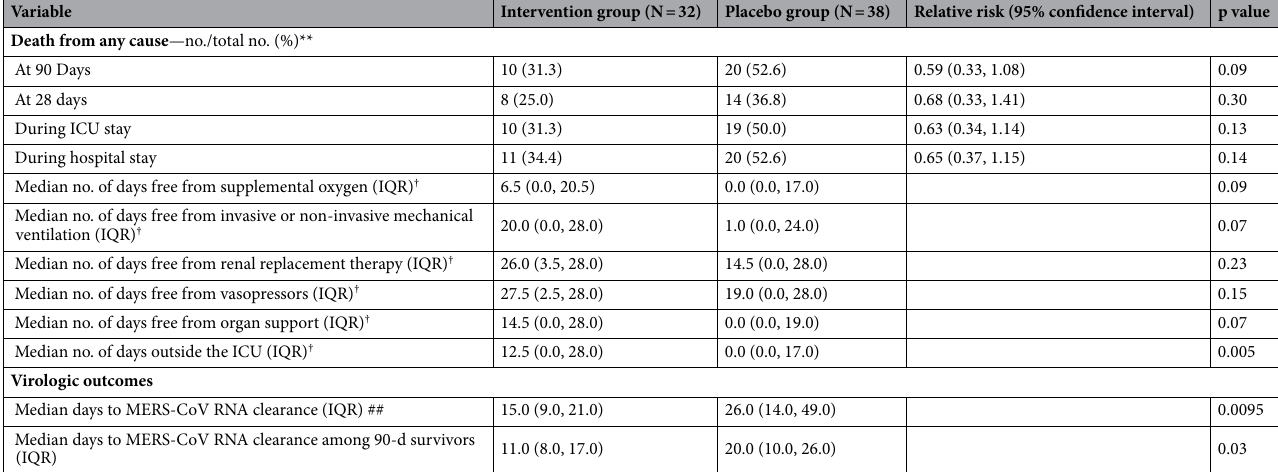
Table 2. Outcomes of hospitalized MERS patients included in this study. Calculations of days free from supplemental oxygen, renal replacement therapy, mechanical ventilation, vasopressors, extracorporeal circulation support-, organ support and days outside the ICU were based on 28 days of observation. For categorical variables, chi-square test was used to calculate p values. For continuous variables, Mann–Whitney U test was used to calculate p value. ##Days to clearance of MERS-CoV RNA were censored by death or hospital